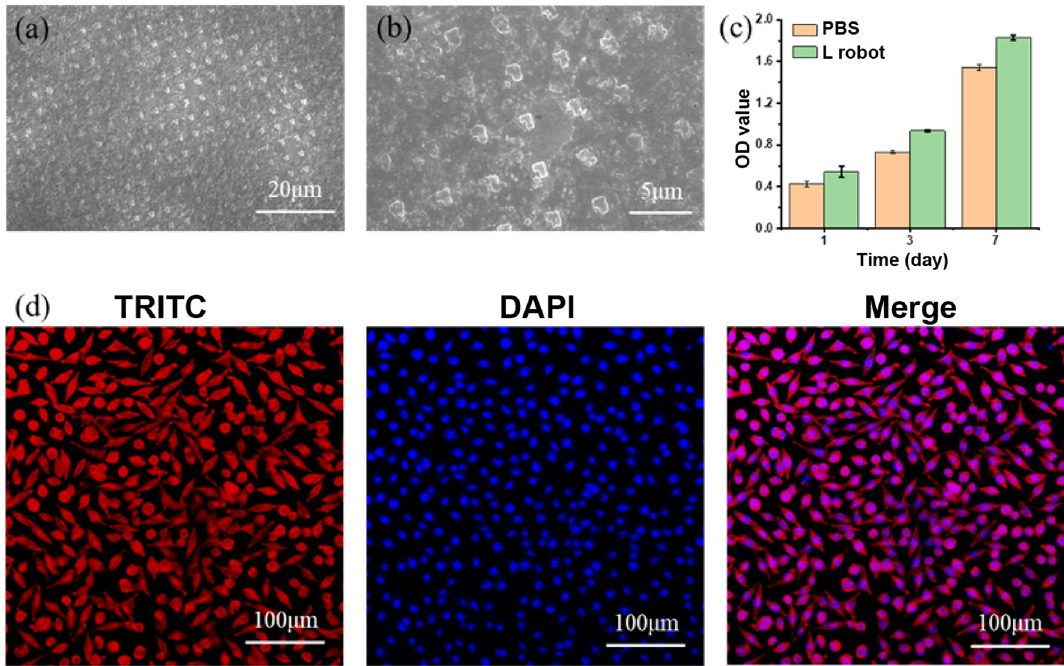
Figure 4. Cell cytotoxicity tests with mouse fibroblasts L929 cells. SEM image ( a ) and a zoom-in view ( b ) of L-shaped robot cultured with cells. ( c ) cell viability test using CCK-8 assay on days of 1 and 3. ( d ) Immunofluorescence staining, nuclei were stained with DAPI (blue), and F-actin was stained with TRITC- phalloidin